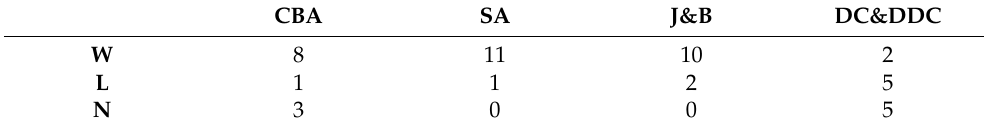
Table 9. Statistically significant wins/losses counts of CCC3 method on the number of